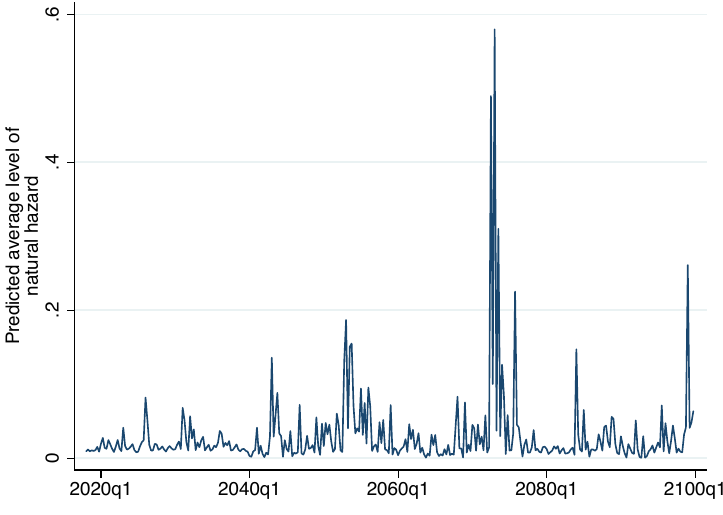
Figure 6. Quarterly level of flooding hazard as the predicted average levels in CRB Census blocks until 2100. Predictions based on IPSL-CM5A-LR